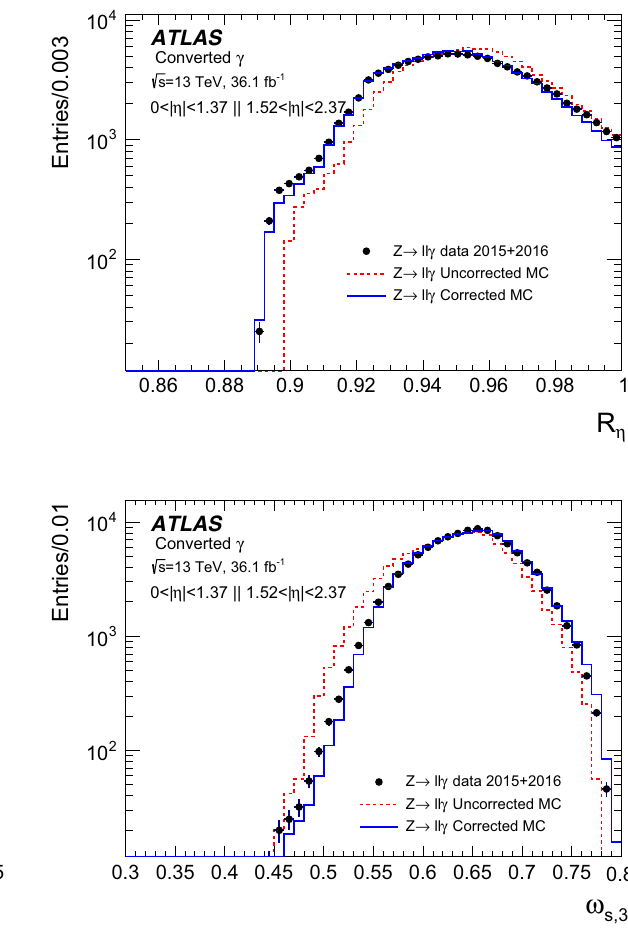
Fig. 3 Distributions of the calorimetric discriminating variables R η and w s 3 for converted and unconverted photon candidates with E T ∈ [ 10 , 50 ] GeV and | η | < 2 . 37 (excluding 1 . 37 ≤ | η | < 1 . 52) selected from (cid:4) + (cid:4) − γ events(blackdots).Thedistributionsfortruephotonsfrom